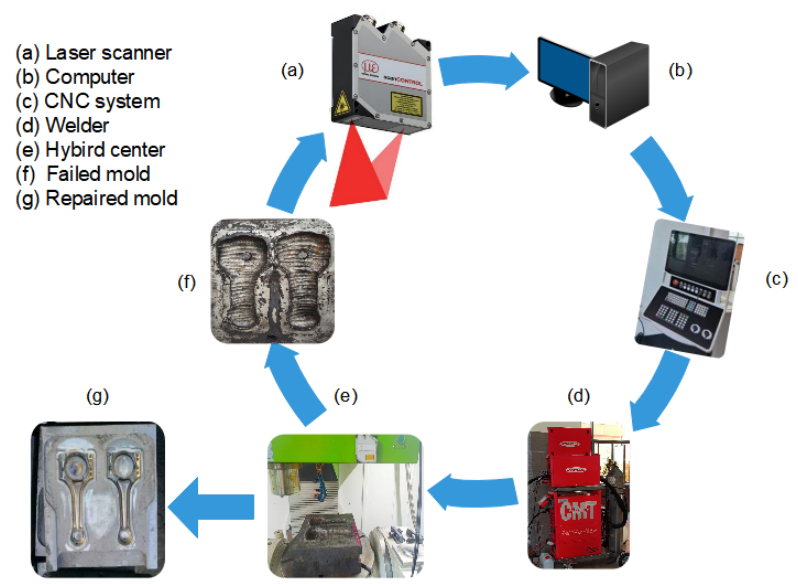
Figure 5. The Wire Arc Additive Manufacturing (WAAM) of the mold repair system based on a 3D profile laser scanner.